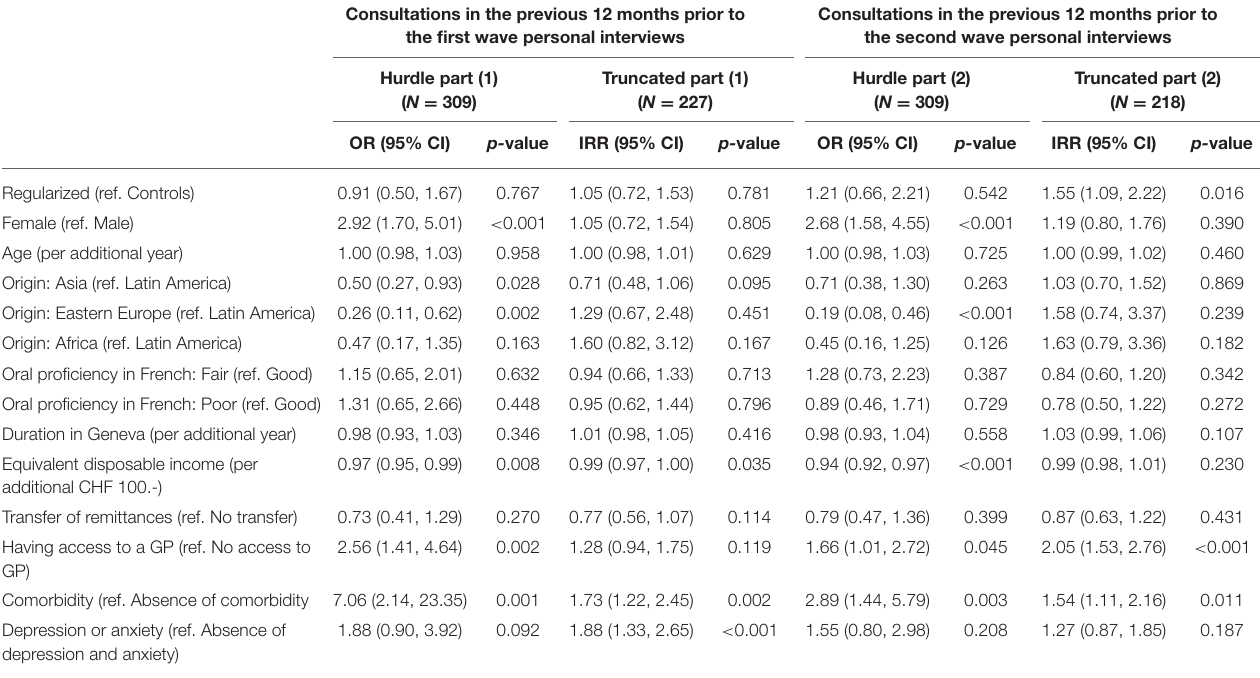
Consultations in the previous 12 months prior to the second wave personal interviews